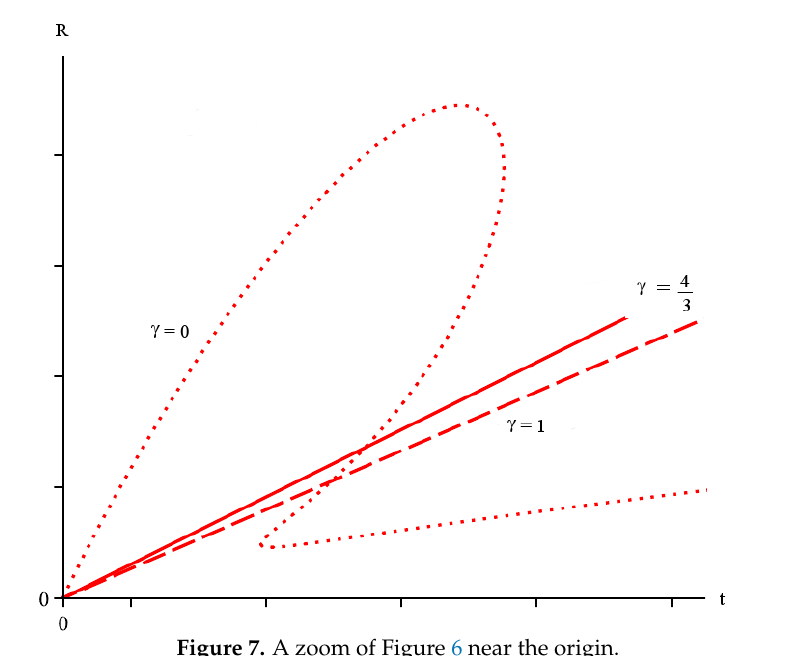
Figure 7. A zoom of Figure 6 near the